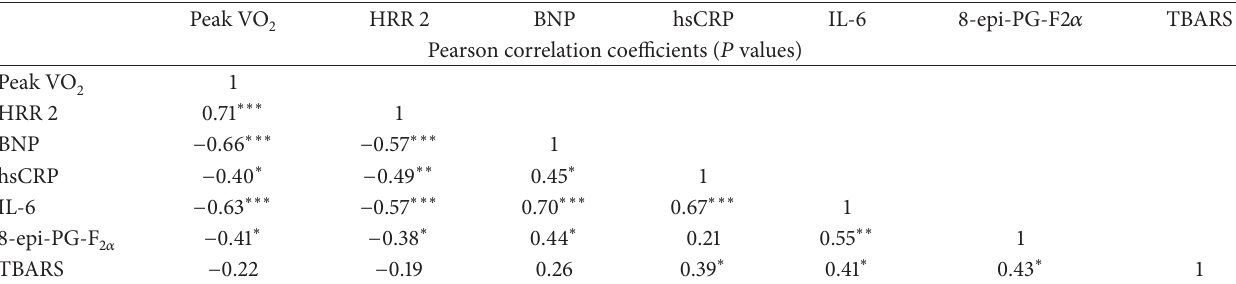
for the study population. 2